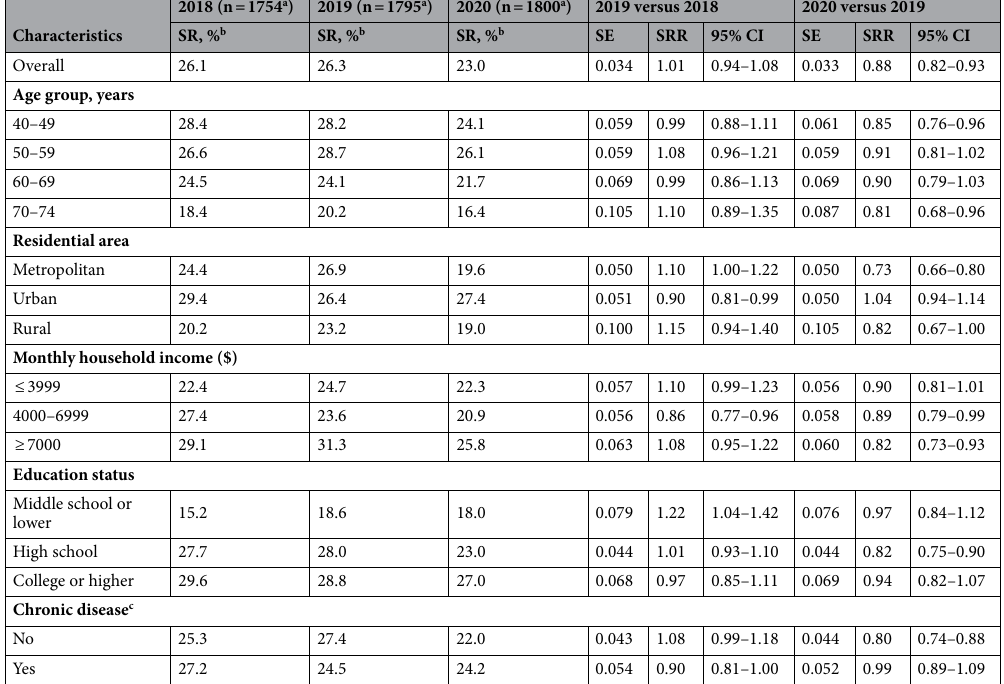
Table 3. Breast cancer screening rates for the period 2018–2020. SR screening rate, SRR screening rate ratio, SE standard error, CI confidence interval. a The n value is the number of women eligible for breast cancer screening (aged over 40 years); b SRs were defined as the proportion of screened women within the last 1 year; Weighting values from the Population and Housing Census were applied to calculate the SRs; c Chronic disease, women who are diagnosed with any of the following diseases: hypertension, diabetes, tuberculosis, hepatitis B, hepatitis C, liver cirrhosis, chronic gastritis, stomach/duodenal ulcers, polyps, benign breast diseases, uterine myoma, and